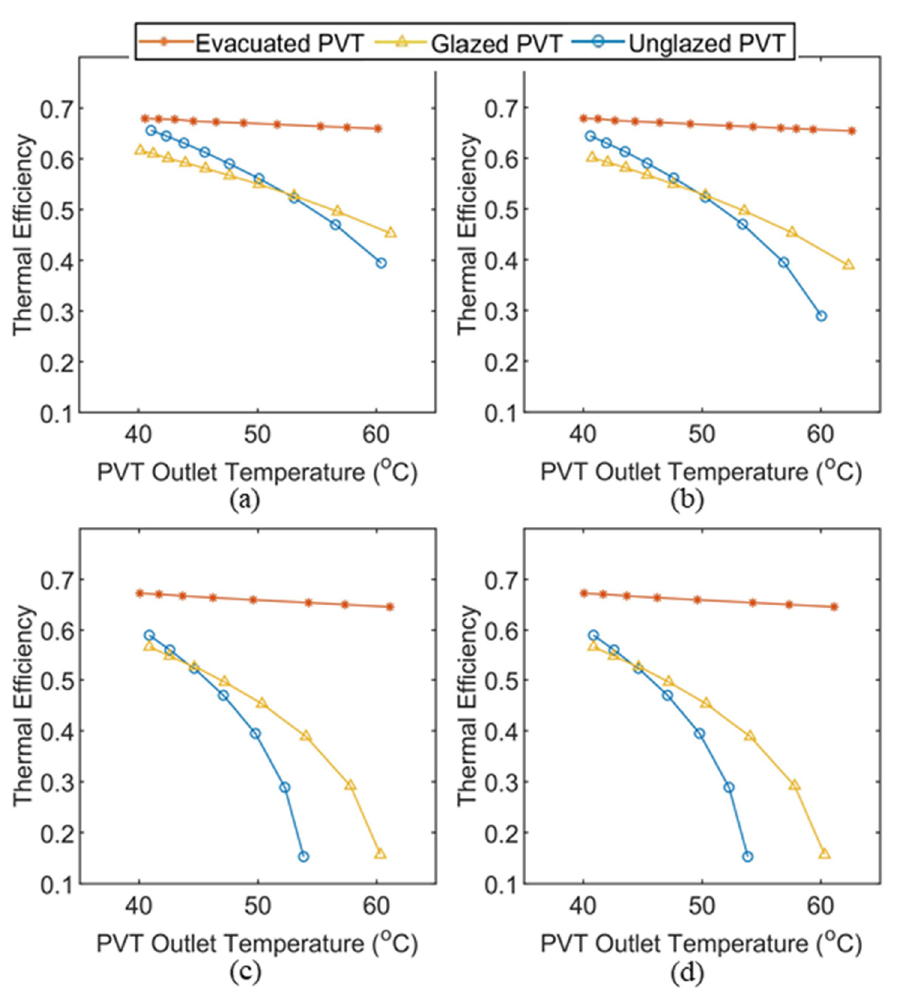
Figure 5. Thermal efficiency of different PVT systems versus outlet temperature at irradiance of: ( a ) 1000 W/m 2 ; ( b ) 900 W/m 2 ; ( c ) 800 W/m 2 ; ( d ) 700 W/m 2 .